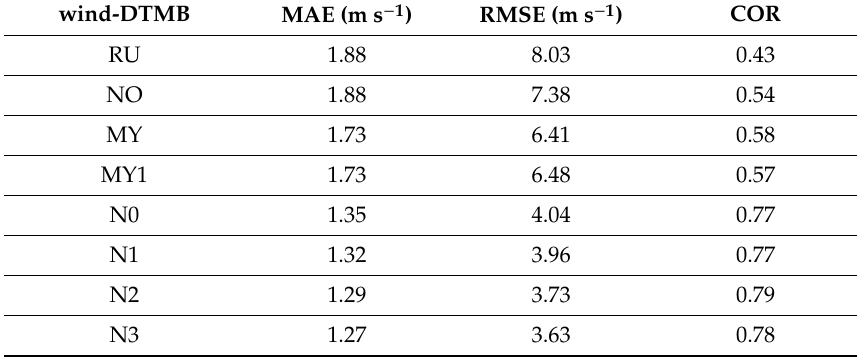
Table A3. Mean absolute error (MAE), root mean square error (RMSE), and correlation coe ffi cient (COR) for surface wind at Habib Bourguiba (Tunisia); meteorological aviation reporting (METAR) station code =